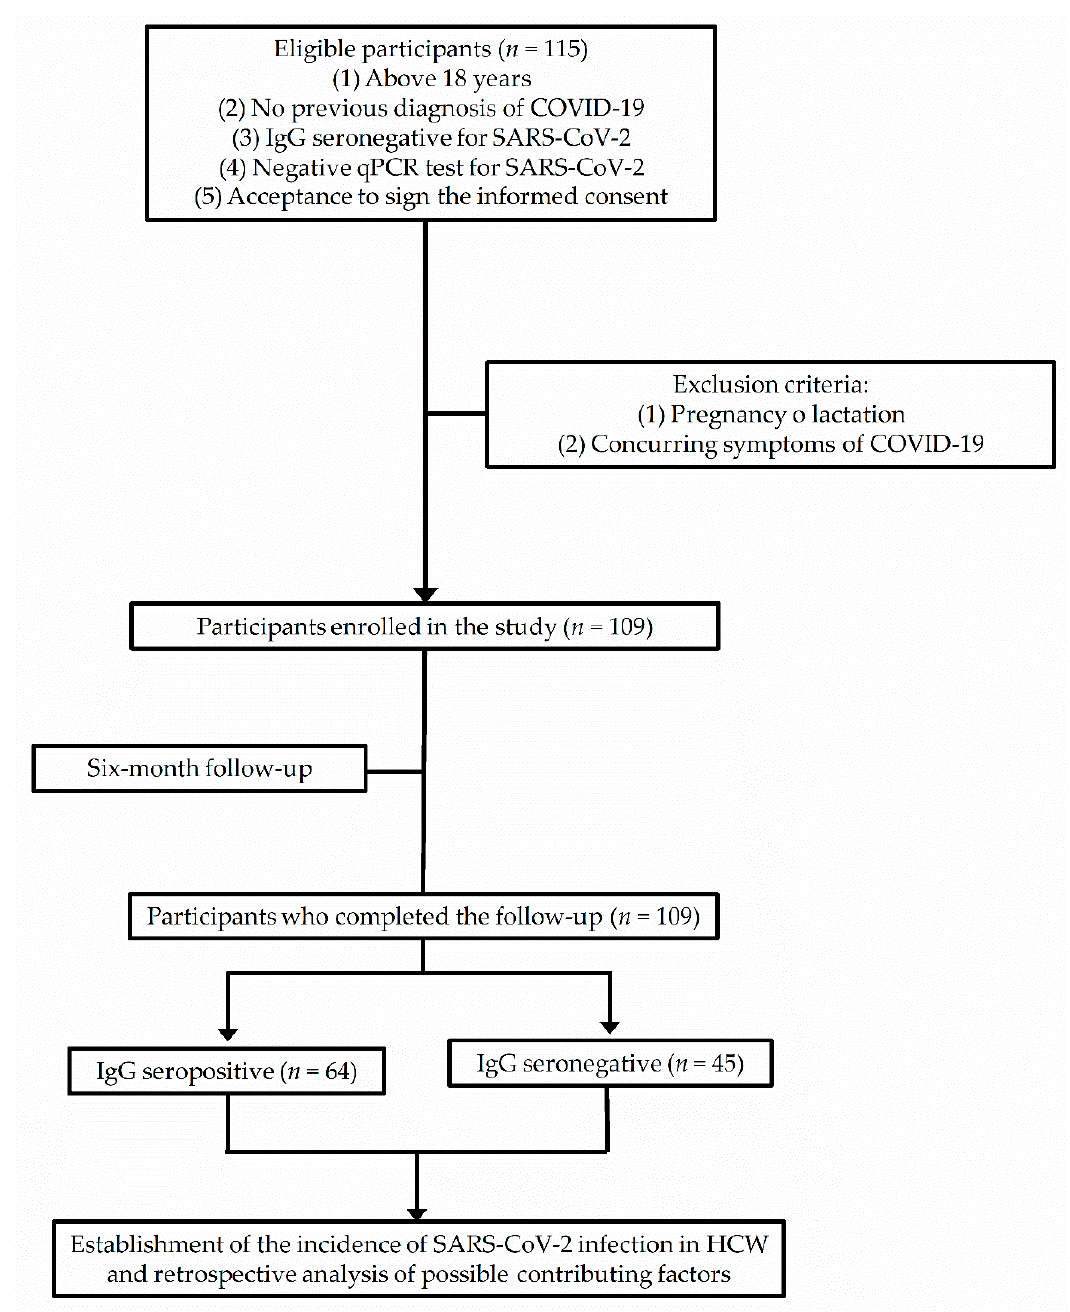
Figure 1. Schematic flow chart showing the selection process of participants enrolled in the study based on the inclusion and exclusion criteria. We conducted the enrollment of participants in strict adherence to the principles of the 1964 Declaration of Helsinki and its posterior amendment in 2013, meeting the STROBE guidelines for reporting observational studies. Abbreviations: IgG, immunoglobulin G; qPCR, quantitative polymerase chain reaction; SARS-CoV-2, severe acute respiratory syndrome coronavirus 2; COVID-19, coronavirus disease 2019; STROBE, Strengthening the Reporting of Observational Studies in Epidemiology; HCW, health care workers.